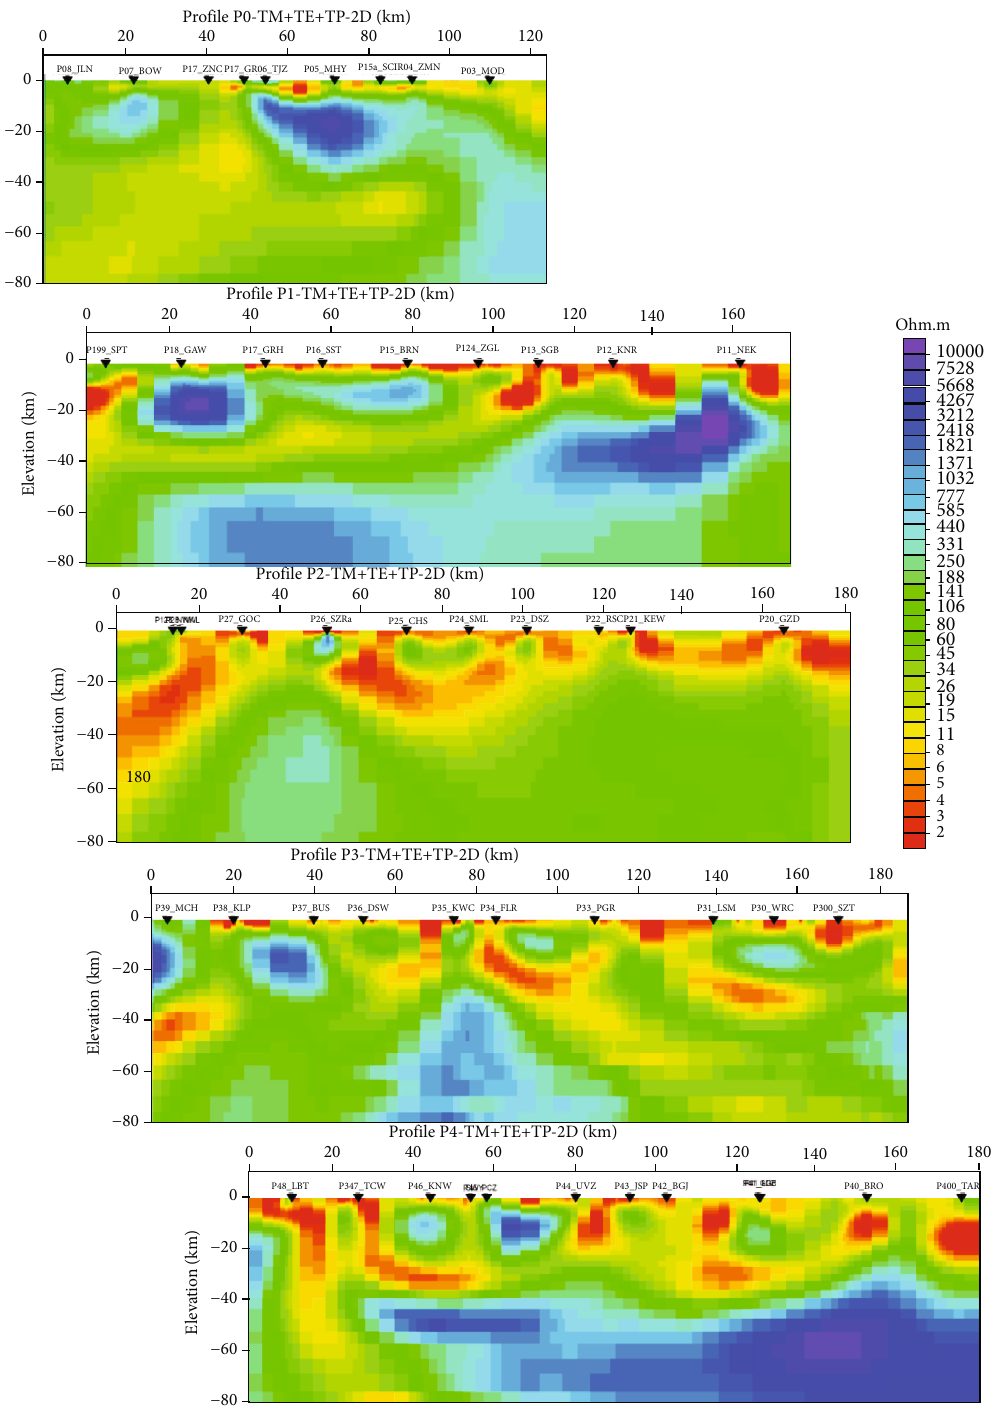
Figure 9: Comparison of 2D cross-sections of the resistivity distribution for 2D NLCG